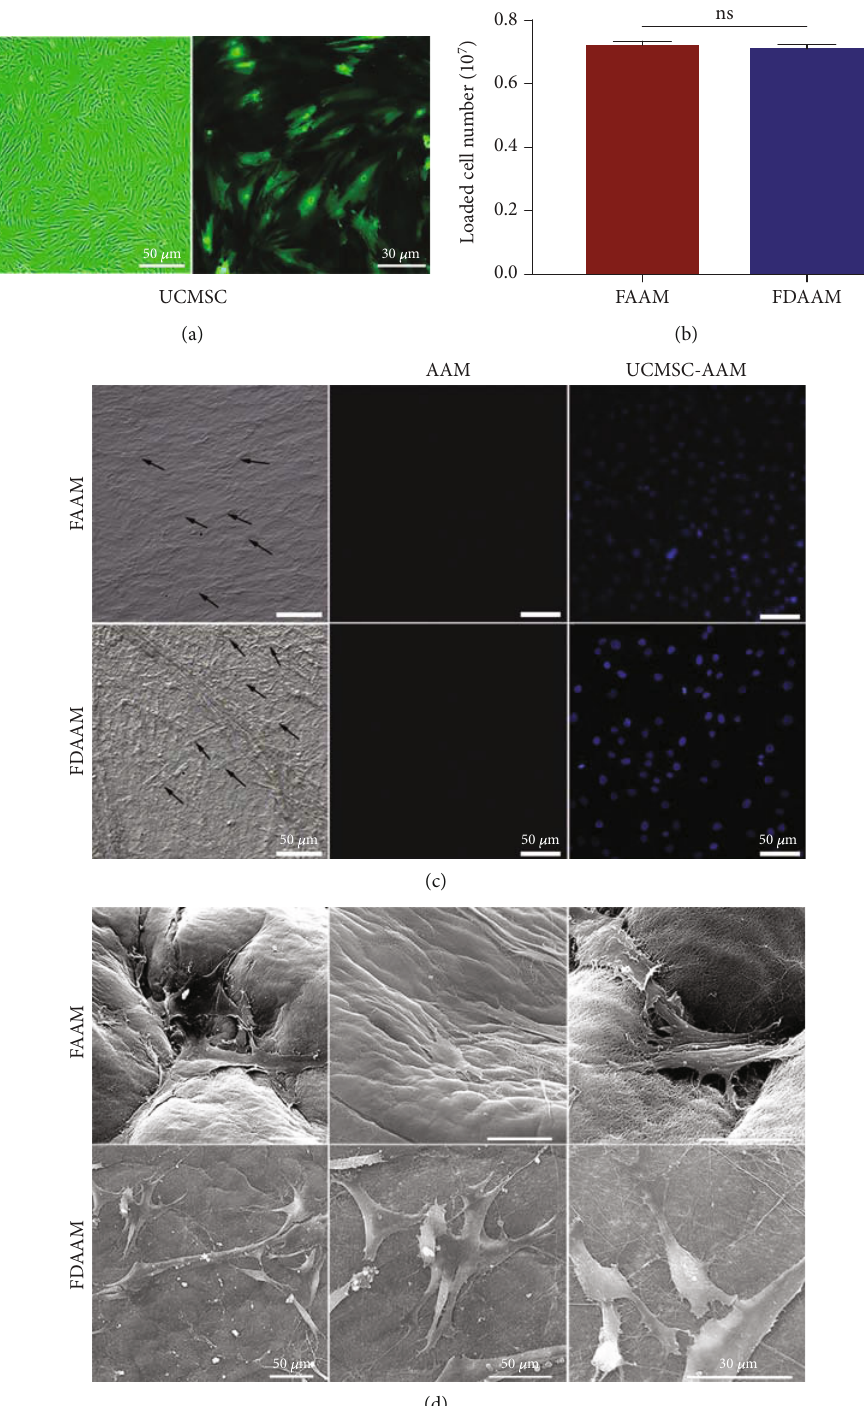
Figure 2: Establishment of UCMSC-AAM complex. (a) Morphology of human UCMSCs under a light microscope. Scale bars, 50 μ m. UCMSCs were observed by the green fl uorescence of green fl uorescent protein under a fl uorescence microscope. Scale bars, 30 μ m. (b) Statistical analysis of the number of loaded cells on FAAM and FDAAM counted from six randomly selected pieces (ns: P > 0 : 05 ). Data were presented as mean ± standard deviation . (c) UCMSCs were detected on FAAM and FDAAM under light microscope and fl uorescence microscope. Scale bars, 50 μ m. Arrowheads indicate seeded UCMSCs. Cell nuclei were stained with DAPI (blue).